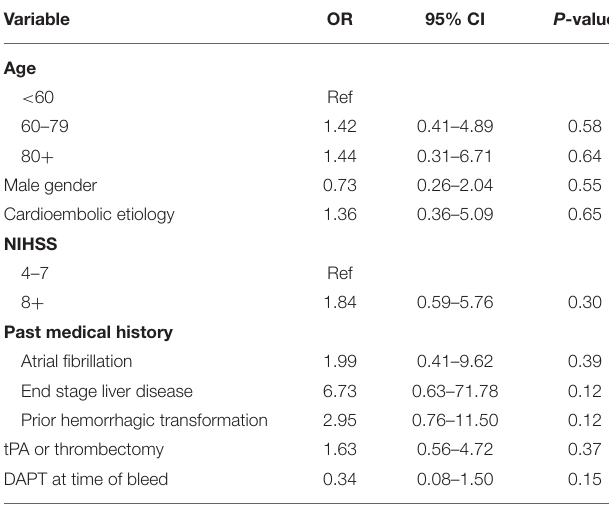
TABLE 5 | Univariate analysis. TABLE 6 | Multivariate analysis for variables associated with Major